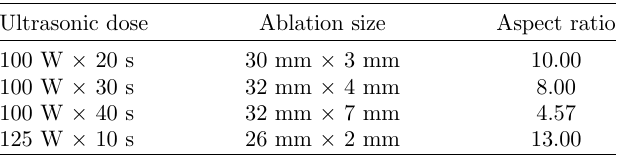
Table 2. Low dose ablation size statistics. Ultrasonic dose Ablation size Aspect